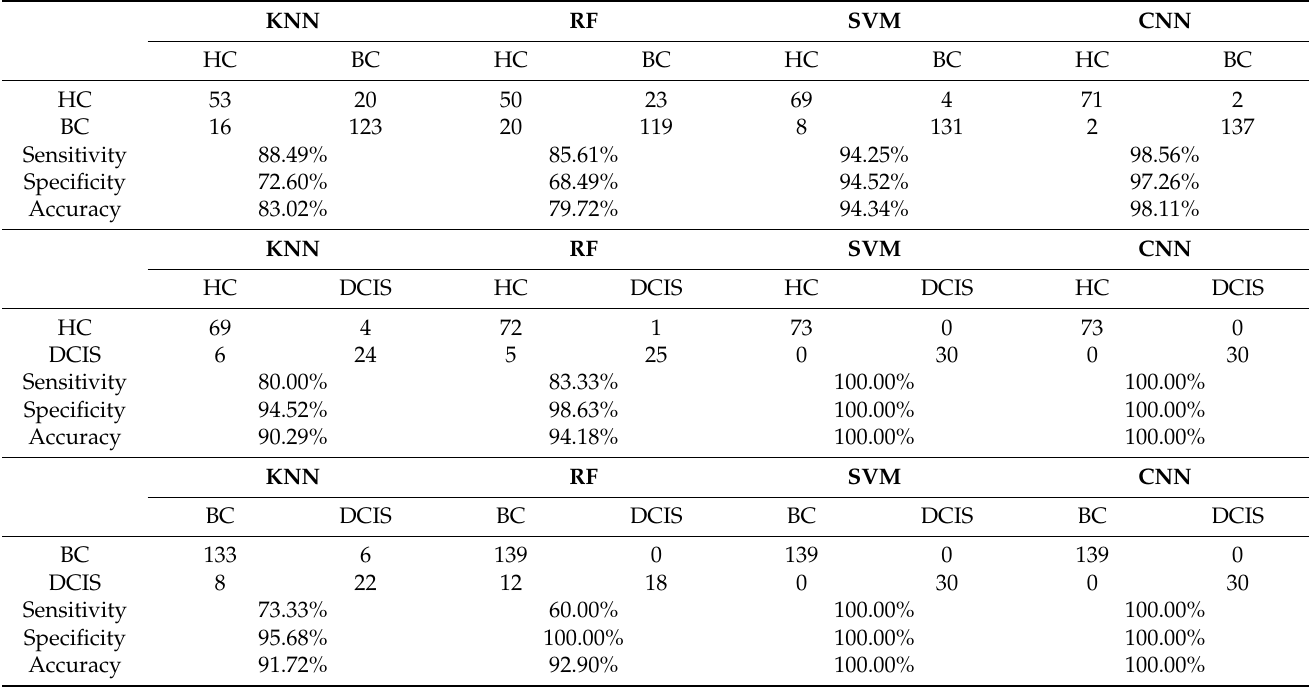
Table 5. Confusion matrix for binary classification of four